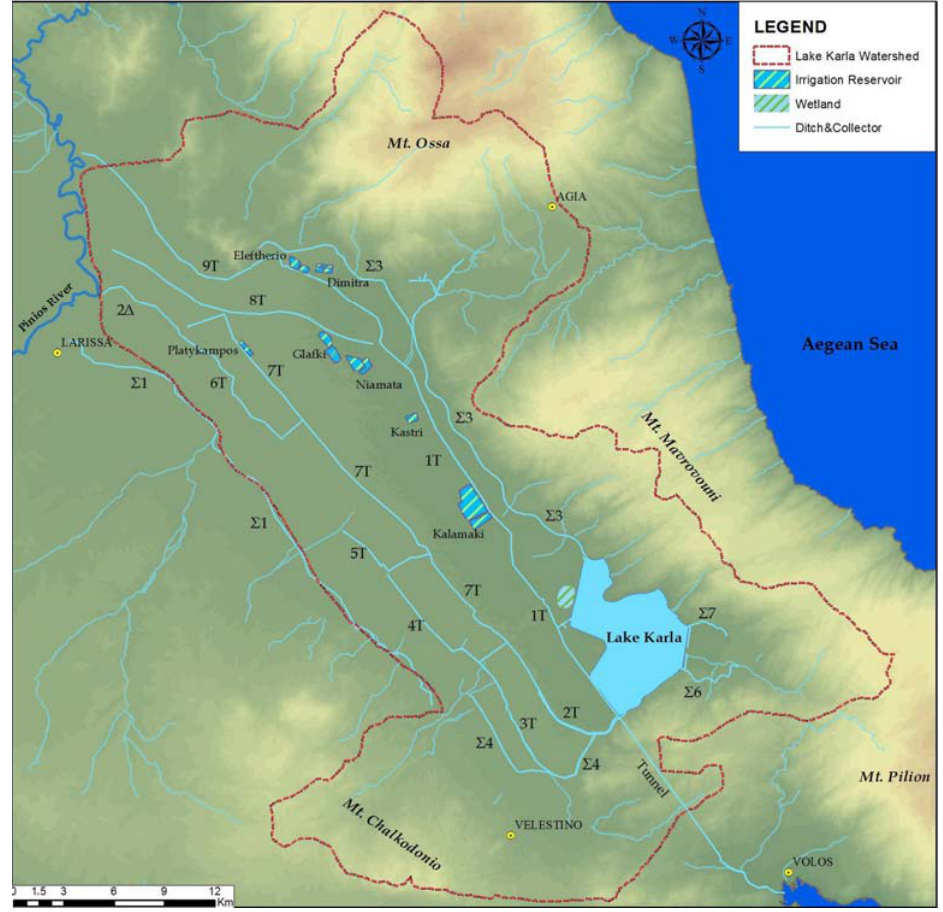
Figure 1. Orientation map of Lake Karla watershed indicates the irrigation reservoirs, the ditches and collectors and the Lake